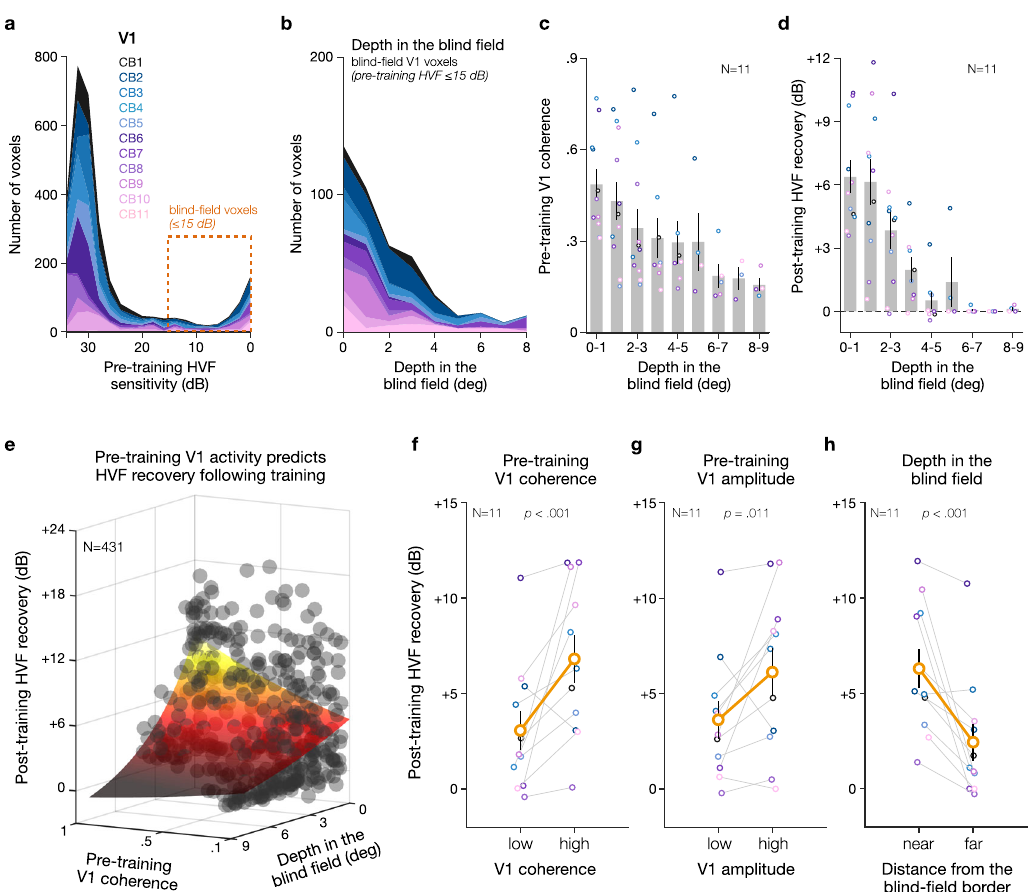
Fig. 4 Spared pre-training V1 activity predicts post-training Humphrey ’ s Visual Field (HVF) recovery in the blind fi eld of chronic CB patients. a Distribution plot of V1 voxels in damaged hemispheres as a function of the pre-training HVF sensitivity (using 2 ± 1 dB steps). b Distribution plot of V1 voxels in damaged hemispheres representing regions of the blind fi eld ( ≤ 15 dB pre-training HVF sensitivity) prior to training as a function of the depth in the blind fi eld (i.e., distance from the blind- fi eld border) using 1 ± 0.5 deg steps. Each color corresponds to a single CB patient. Note the preferential location of these voxels near the blind- fi eld border (i.e., 0 deg). c , d Consistent with enhanced plastic potential along the blind- fi eld border of CB patients, spared blind- fi eld locations closer to the blind- fi eld border showed stronger visually-evoked V1 response coherence prior to training, as well as greater HVF change (in dB of sensitivity) from pre- to post-training. Bars represent average estimates across CB patients (±1SEM), with individual dots corresponding to individual CB patients. e The strength of pre-training visually-evoked responses and the blind- fi eld depth of V1 voxels representing blind- fi eld locations were predictive of the magnitude of post-training HVF recovery, with a signi fi cant interaction between pre-training V1 coherence and depth in the blind fi eld. Each data point corresponds to a V1 voxel, which were fi t (colored surface) using a generalized linear mixed-effects model with participants as a random effect (adj-r2 = .55). Post-training HVF recovery as a function of pre-training, visually-evoked V1 responses within the blind fi eld ( f : coherence; g : amplitude) computed for each CB patient ( N = 11). Data were split using the group median for illustration purposes only (coherence: 0.37; amplitude: 0.54); p -values were computed from the generalized linear mixed-effects analyses on unbinned data. Error bars correspond to ±1SEM, with gray lines representing individual subjects. ( h ) Same as ( f , g ) but as function of the blind- fi eld depth (median split: 1.7 of V1 pRFs (18 ± 15%) covered parts of the blind fi eld prior to training, providing further evidence that perilesional V1 cortex in chronic CB patients retains spared representations of the blind fi eld 33,38,41,42 . Two-way repeated-measures ANOVAs on pRF estimates (Fig. 7 and Supplementary Fig. S5) indicated no effect of training (pre- vs. post-training), or interaction between training and HVF coverage (blind- fi eld vs . intact HVF) on the variance explained (r 2 ), preferred eccentricity, position depth in the blind- fi eld, or the number of V1 pRFs (all p > 0.1). As expected, there were fewer V1 pRFs covering blind- fi eld regions than pRFs covering visual- fi eld locations with preserved HVF sensitivity (Supplementary Fig. S5c; F(1,7) = 32.95, p < 0.001, η p 2 = 0.83). Overall, blind- fi eld pRFs had a similar variance explained (Sup- plementary Fig. S5a; F(1,7) = 2.22, p = 0.180, η p 2 = 0.24), were by de fi nition located near the blind- fi eld border (Fig. 7b; F(1,7) = 61.32, p < 0.001, η p 2 = 0.9), and were both more